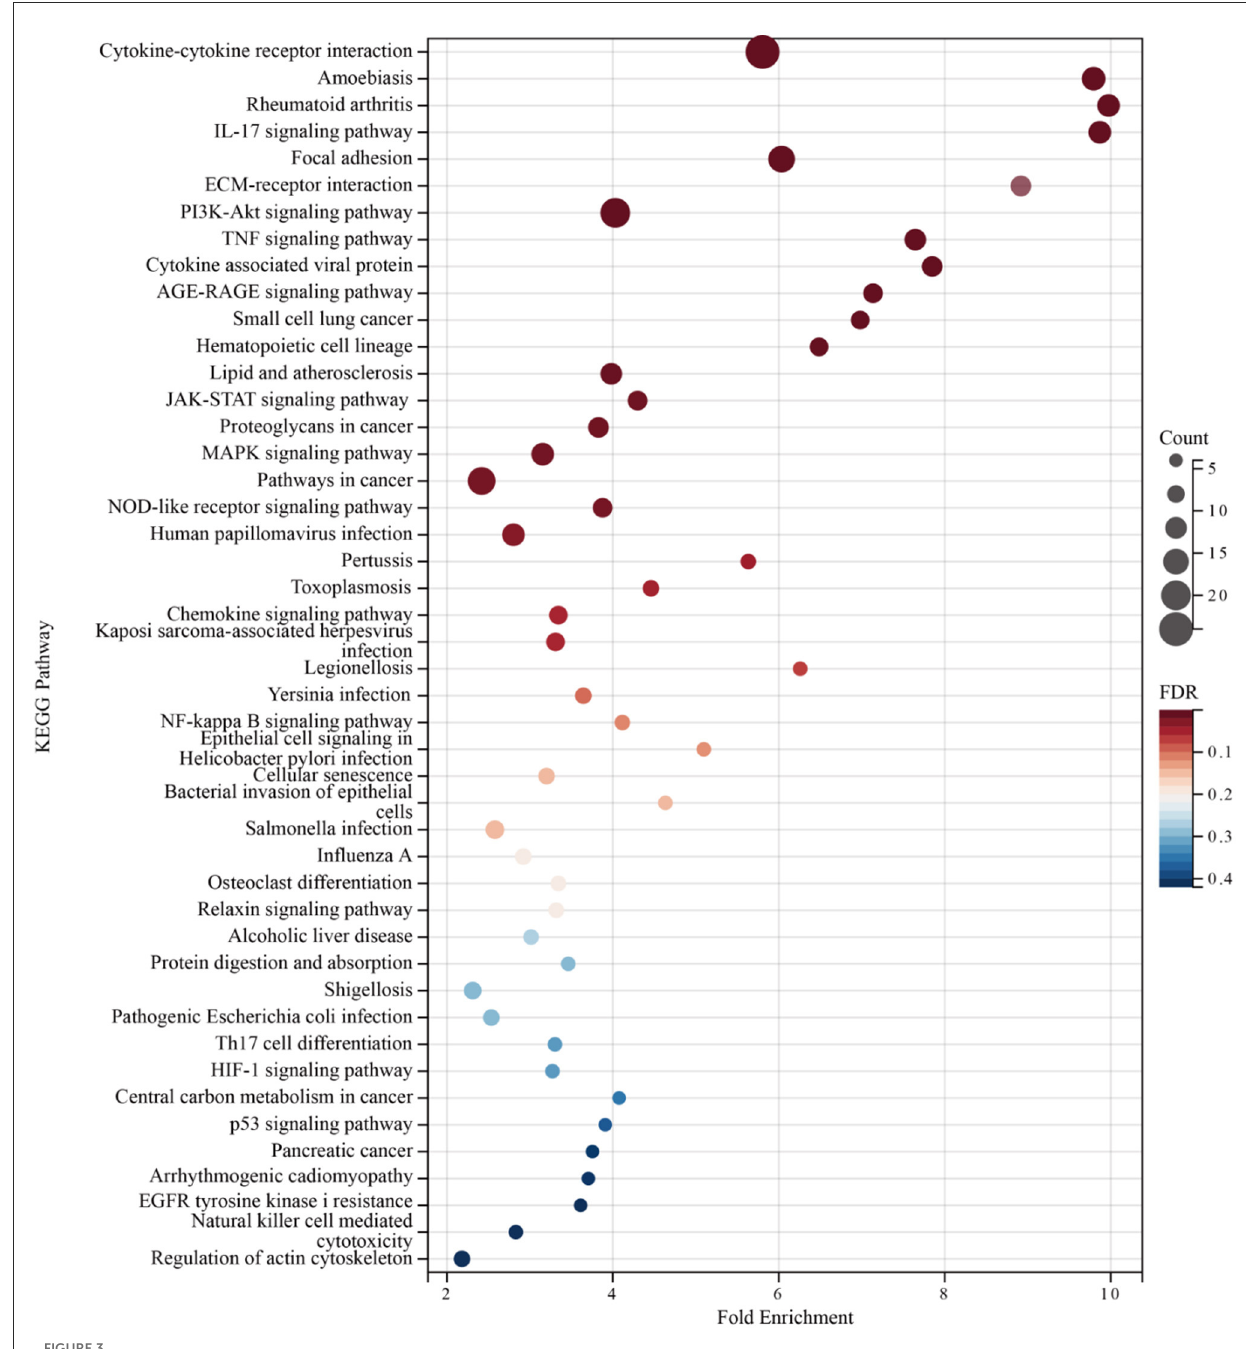
FIGURE3 KEGG pathway enrichment analysis of EREG-correlated genes. The bubble diagram shows the enriched KEGG pathway terms for the genes correlated with EREG in the TCGA CESC dataset. The size of the bubble represents the number of associated genes included in the term. The shade of the color represents the FDR (false discovery